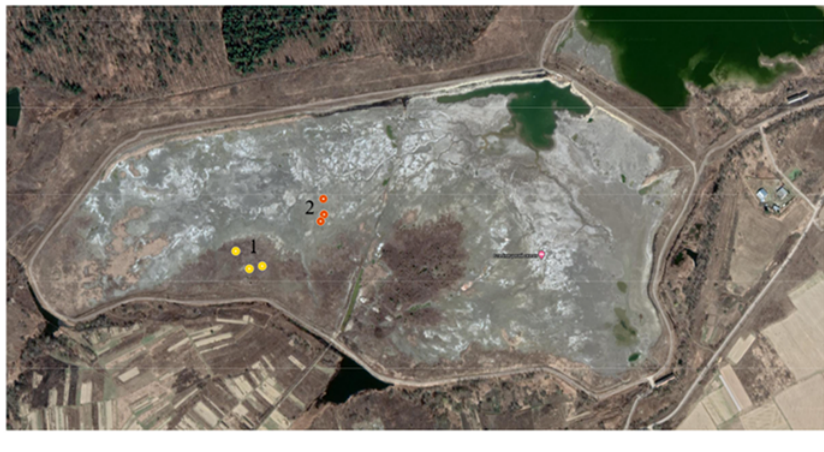
Figure 1 View of Stebnyk tailing (Drohobych District, Lviv region) (1 – control plots; 2 – experiment